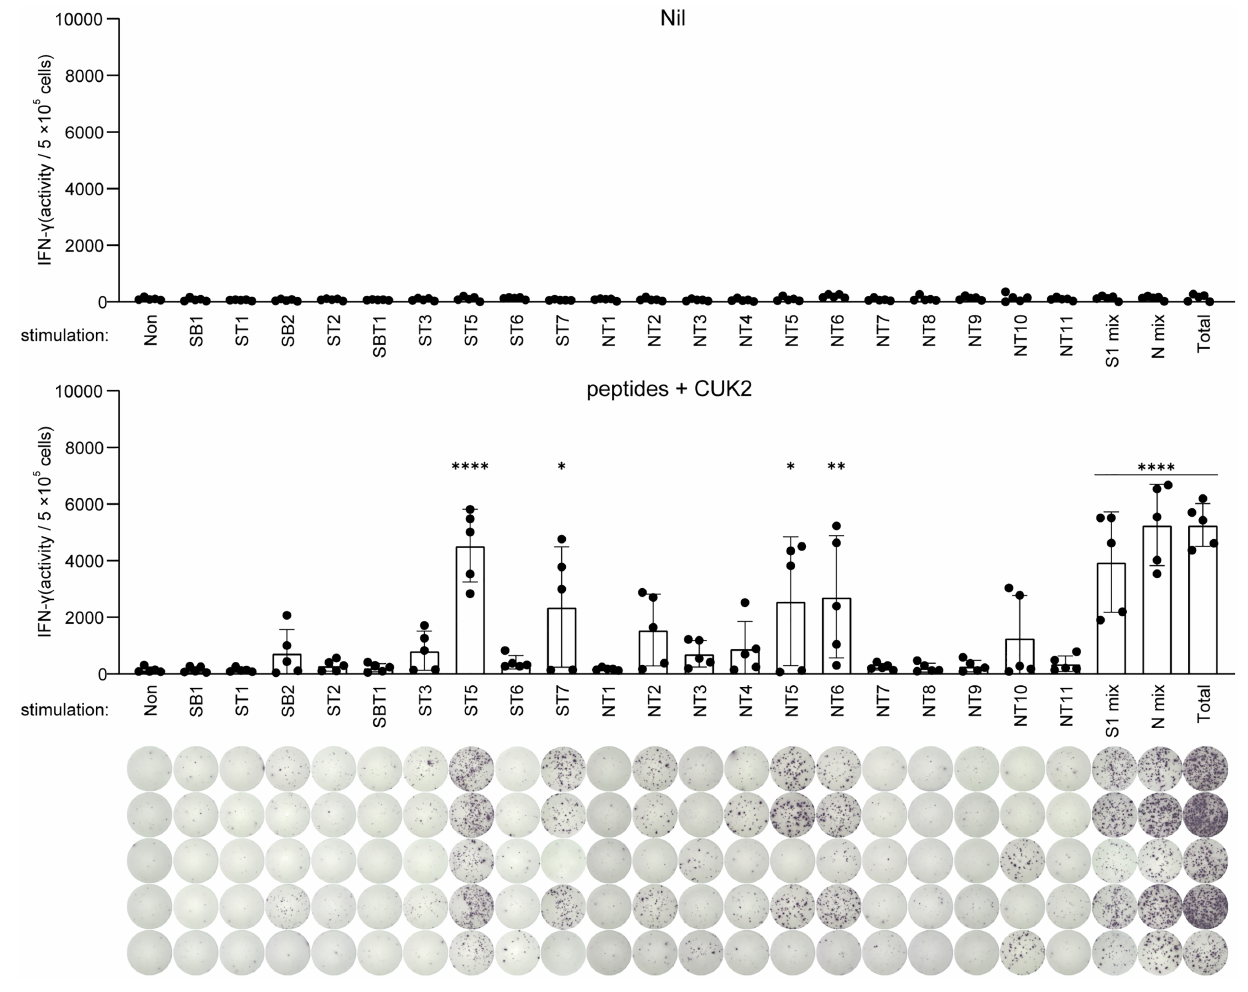
FIGURE 3 | Analysis of IFN- γ -producing T cells after stimulation with each single peptide. C57BL/6 mice were immunized twice at 2-week intervals with the 20 SARS-CoV-2 peptides mixture + CUK2 RNA adjuvant (lower). The nil group included unimmunized C57BL/6 mice as a negative control (upper). Each peptide- specific IFN- γ -producing T cells in the spleen were quantified using ELISPOT. Data represent mean ± SD. * p ≤ 0.05; ** p ≤ 0.01; and **** p ≤